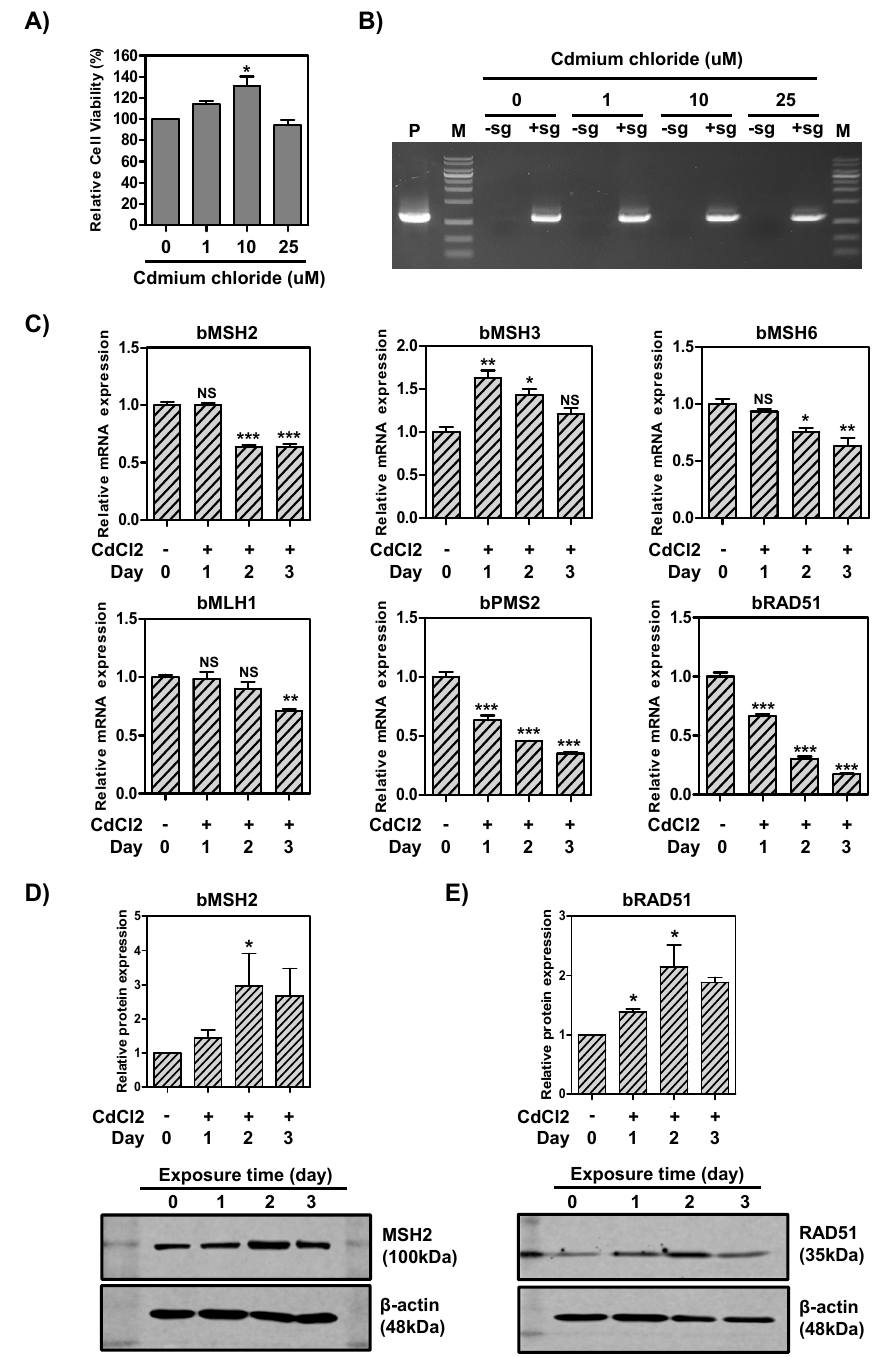
Figure 2. Knock-in efficiency and expression levels of RAD51 and DNA MMR-related genes in MAC-T cells treated with CdCl Polymerase chain reaction analysis of knock-in efficiency. PC, positive control; M, DNA size marker (1 kb ladder). (C) The mRNA levels of Mut S genes ( MSH2 , MSH3 , and MSH6 ), Mut L genes ( MLH1 and PMS2 ) and RAD5 1 gene. (D)-(E) Protein expression of MSH2 and RAD51. RAD51, RAD51 recombinase; MMR, mismatch repair. Error bars show the standard deviation from each sample. NS, no statistical difference; * p<0.05; ** p<0.01; ***